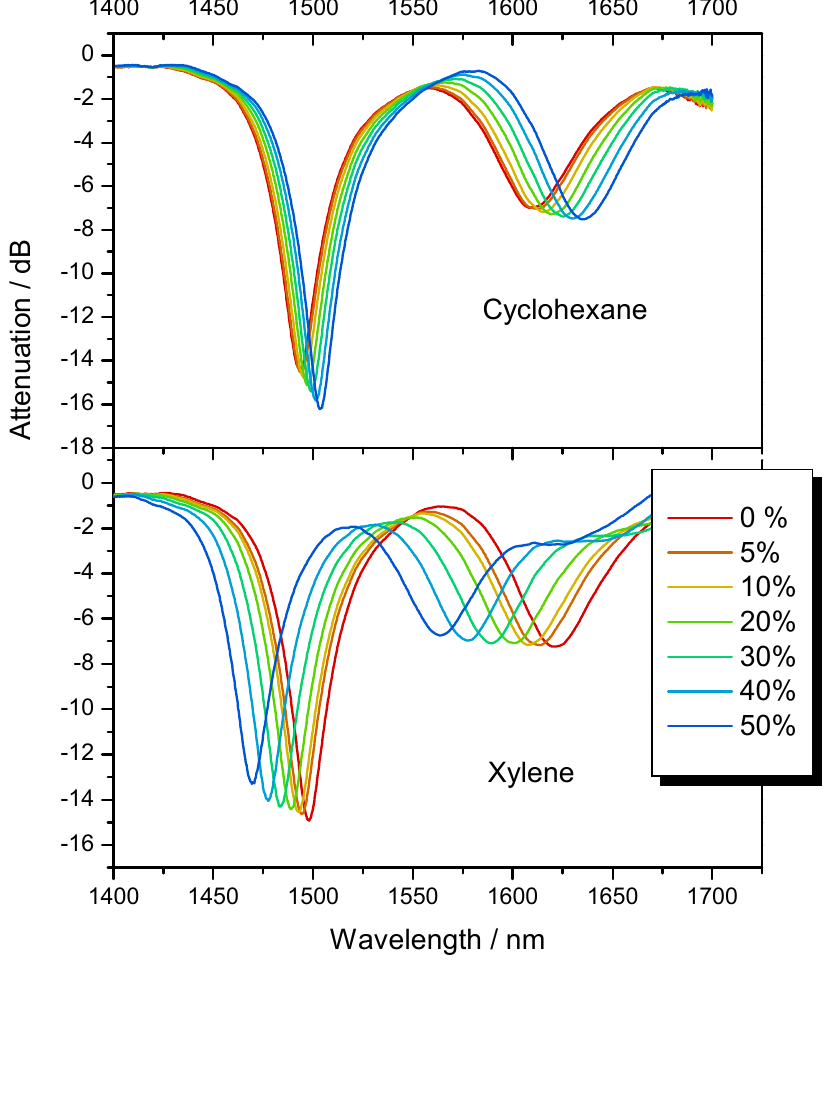
Figure 7. Spectra of a long-period grating (period Λ = 236 μ m), which is coated with a polydimethylsiloxane-based polymer microextraction phase, that contained 8.5% diphenylsiloxane and 0.5% titanium cross linker. Each curve shows two attenuation features corresponding to two different low-order cladding modes. Both peaks shift as the coated LPG is exposed to 0–50% cyclohexane vapor (top panel) and xylene vapor (bottom). As the partial pressure, given here as percent of the saturation pressure, of the gas increases, the refractive index of the polymer coating decreases (increases) upon uptake of cyclohexane (xylene) causing a shift to longer (shorter) wavelengths